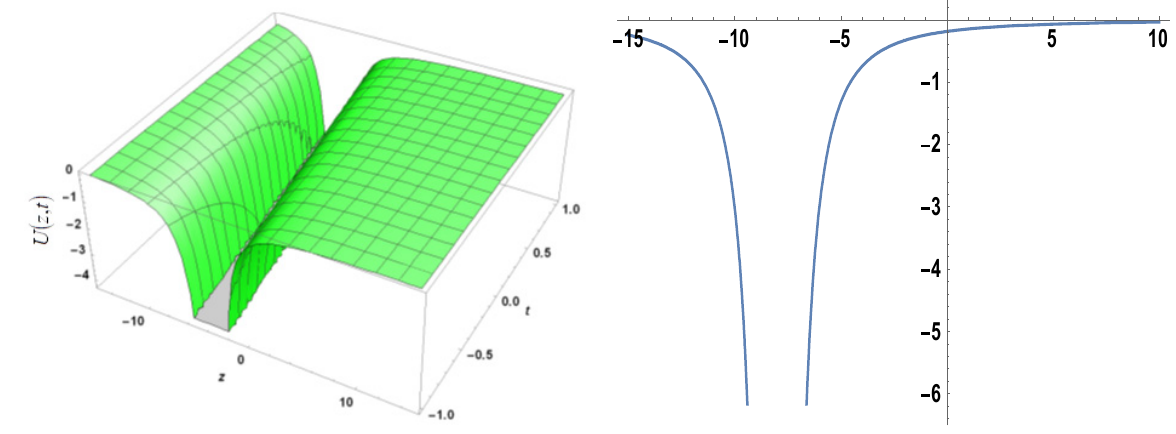
Figure 16. The 3D and 2D plots of Equation (66) for various values of parameters.